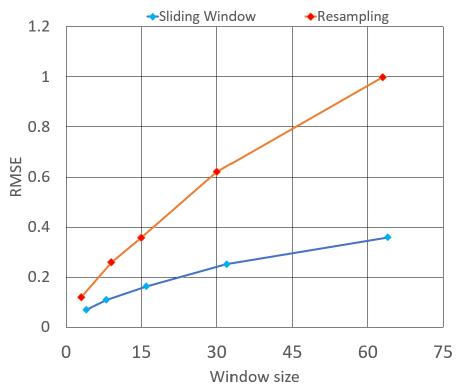
Figure 19. The graph shows a comparison of how Root Mean Square Error (RMSE) increases with higher window sizes for the elevation